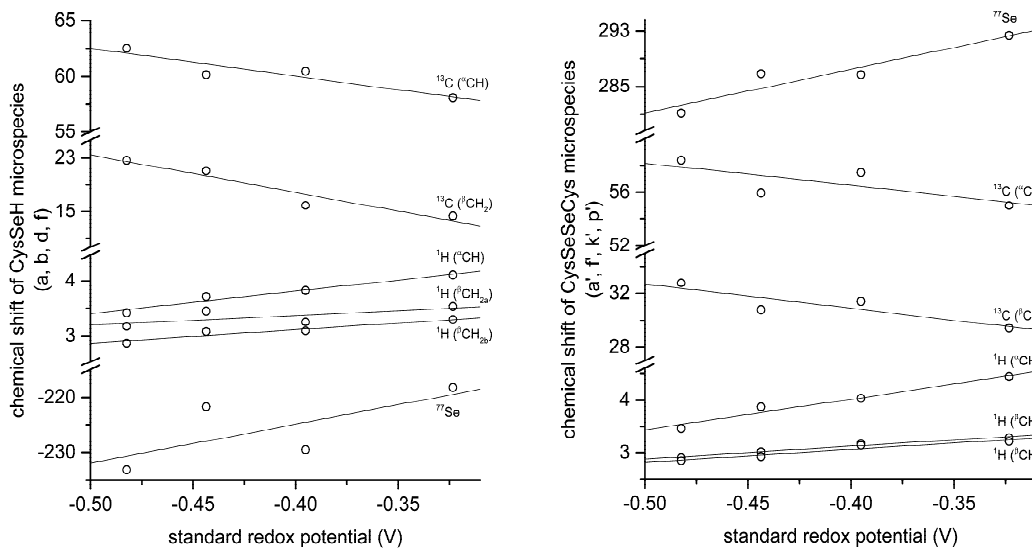
Figure 8. Correlation of selenocysteine standard redox potentials with the corresponding selenocysteine microspecies chemical shifts (left) and selenocystine microspecies chemical shifts (right).